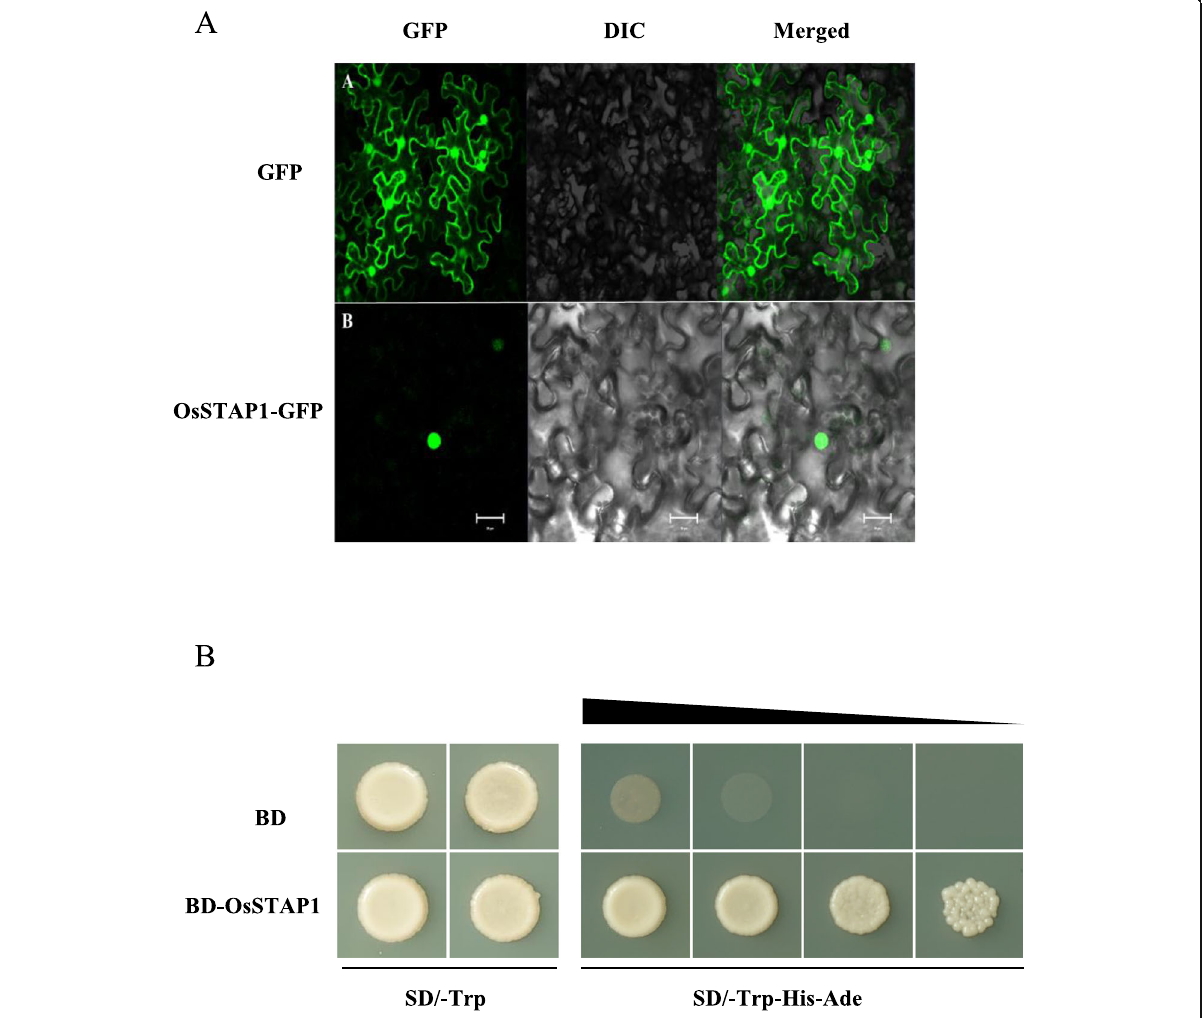
Fig. 3 Transactivation analysis of OsSTAP1 in yeast. a GFP, the positive control, was distributed in the nucleus and cytoplasm, while OsSTAP1-GFP was specifically localized to the nucleus. Scale bars, 10 μ m. b Transcriptional activity identification of OsSTAP1 in yeast with pGBKT7 as the negative control. On the medium of SD/ − Trp-His-Ade, yeast suspension was diluted to 10 − 1 , 10 − 2 , 10 − 3